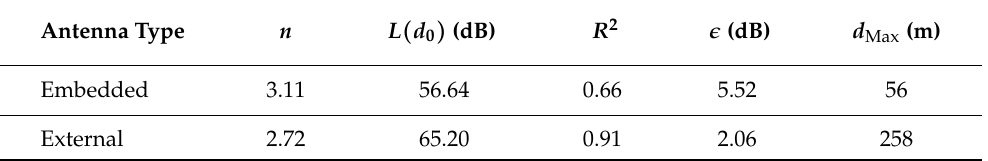
Table 7. Path Loss Regression Coefficients and Statistical Results for the Non-Line-of-Sight